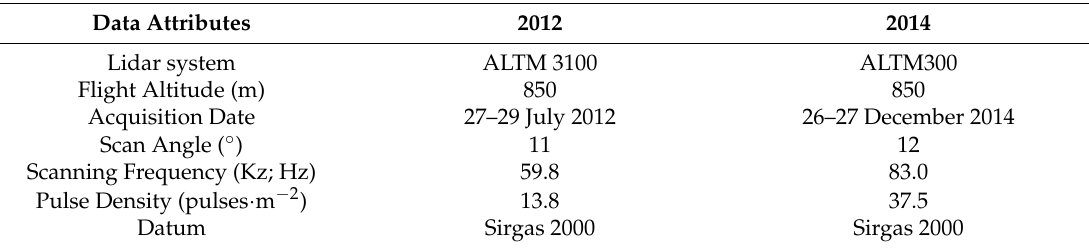
Table 2. Details of lidar data